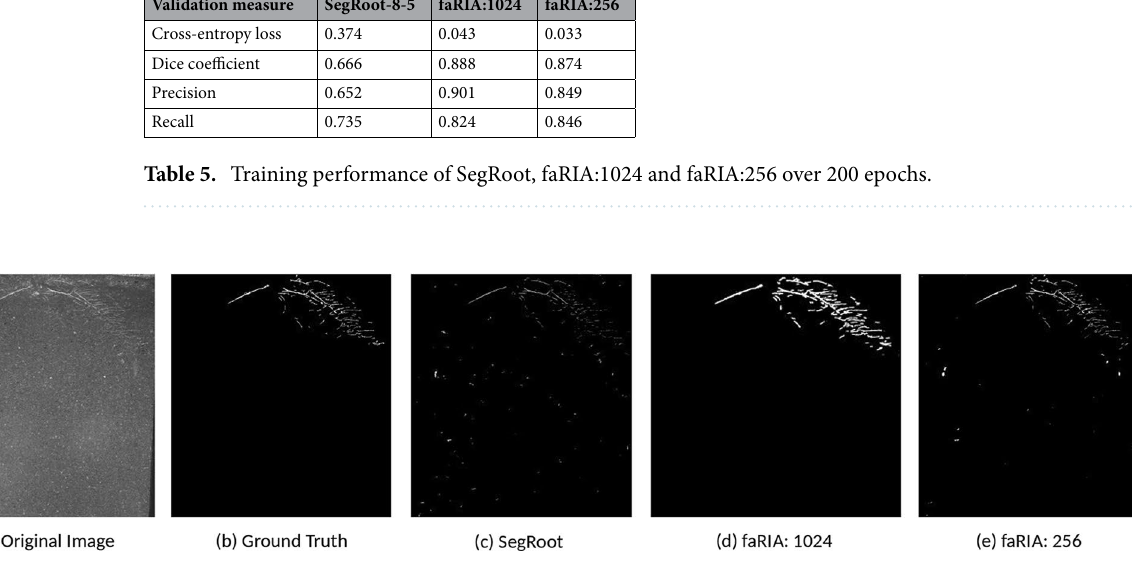
Figure 5. Segmentation performance: ( a ) original image, ( b ) ground truth segmentation by saRIA, ( c ) SegRoot with DC: 0.42, ( d ) faRIA:1024 with DC: 0.44, ( e ) faRIA:256 with DC: 0.83.